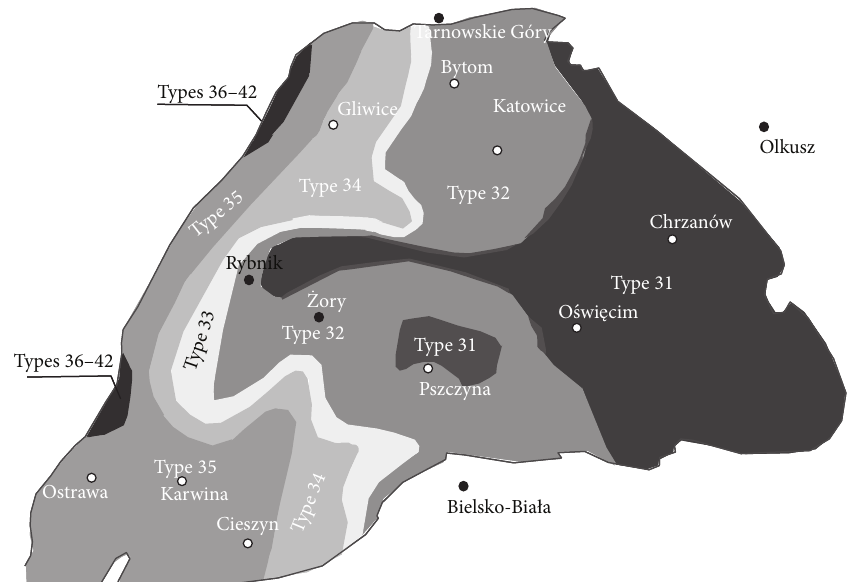
Figure 2: Distribution of coal types on USCB Carboniferous roof